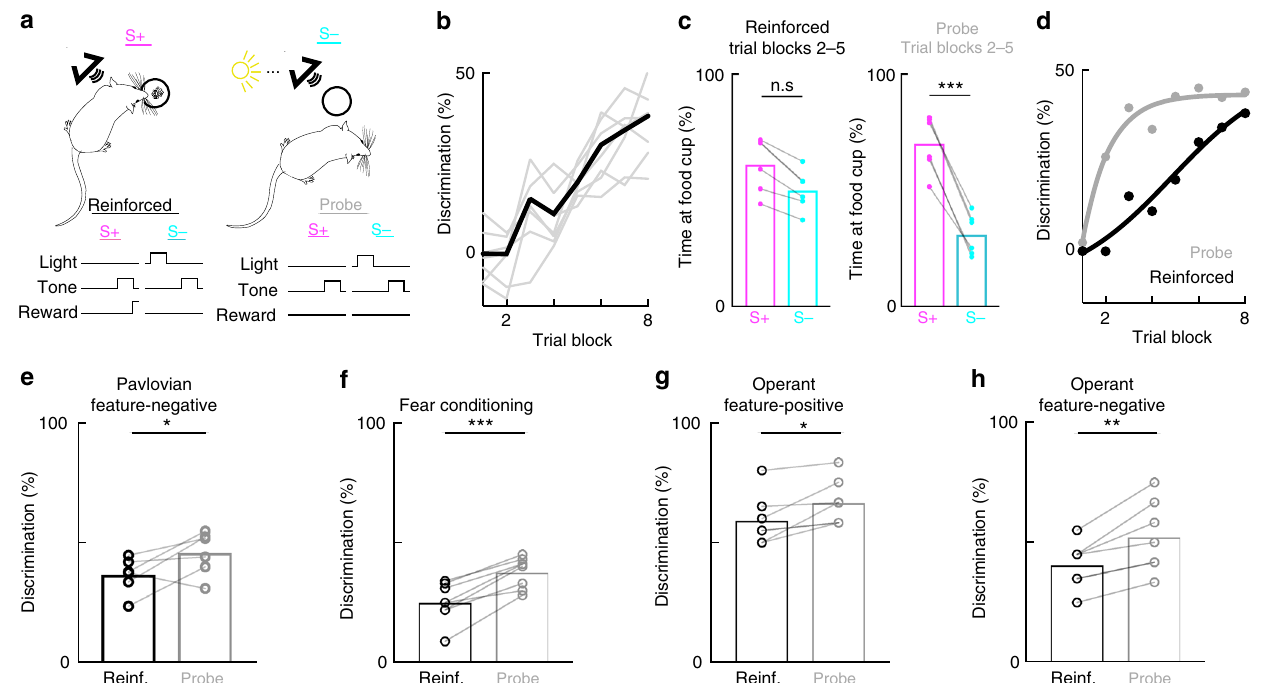
Fig. 2 Dissociation of acquisition and expression generalizes to freely-moving rats. a Behavioral schematic of the discrimination task. b Discrimination between stimuli as a function of trial blocks in the reinforced context; gray lines indicate individual animals, black line is the average performance across animals (peak discrimination: 35.5 ± 3.8%, N = 6 rats). c Left: average time at food cup after S + stimulus (61.2 ± 4.8%, N = 6 rats) and S − stimulus (50.1 ± 3.5%) across trial blocks 2 – 5 in the reinforced context. Right: average time at food cup after S + stimulus (70.1 ± 4.9%, N = 6 rats) and S − stimulus (31.0 ±